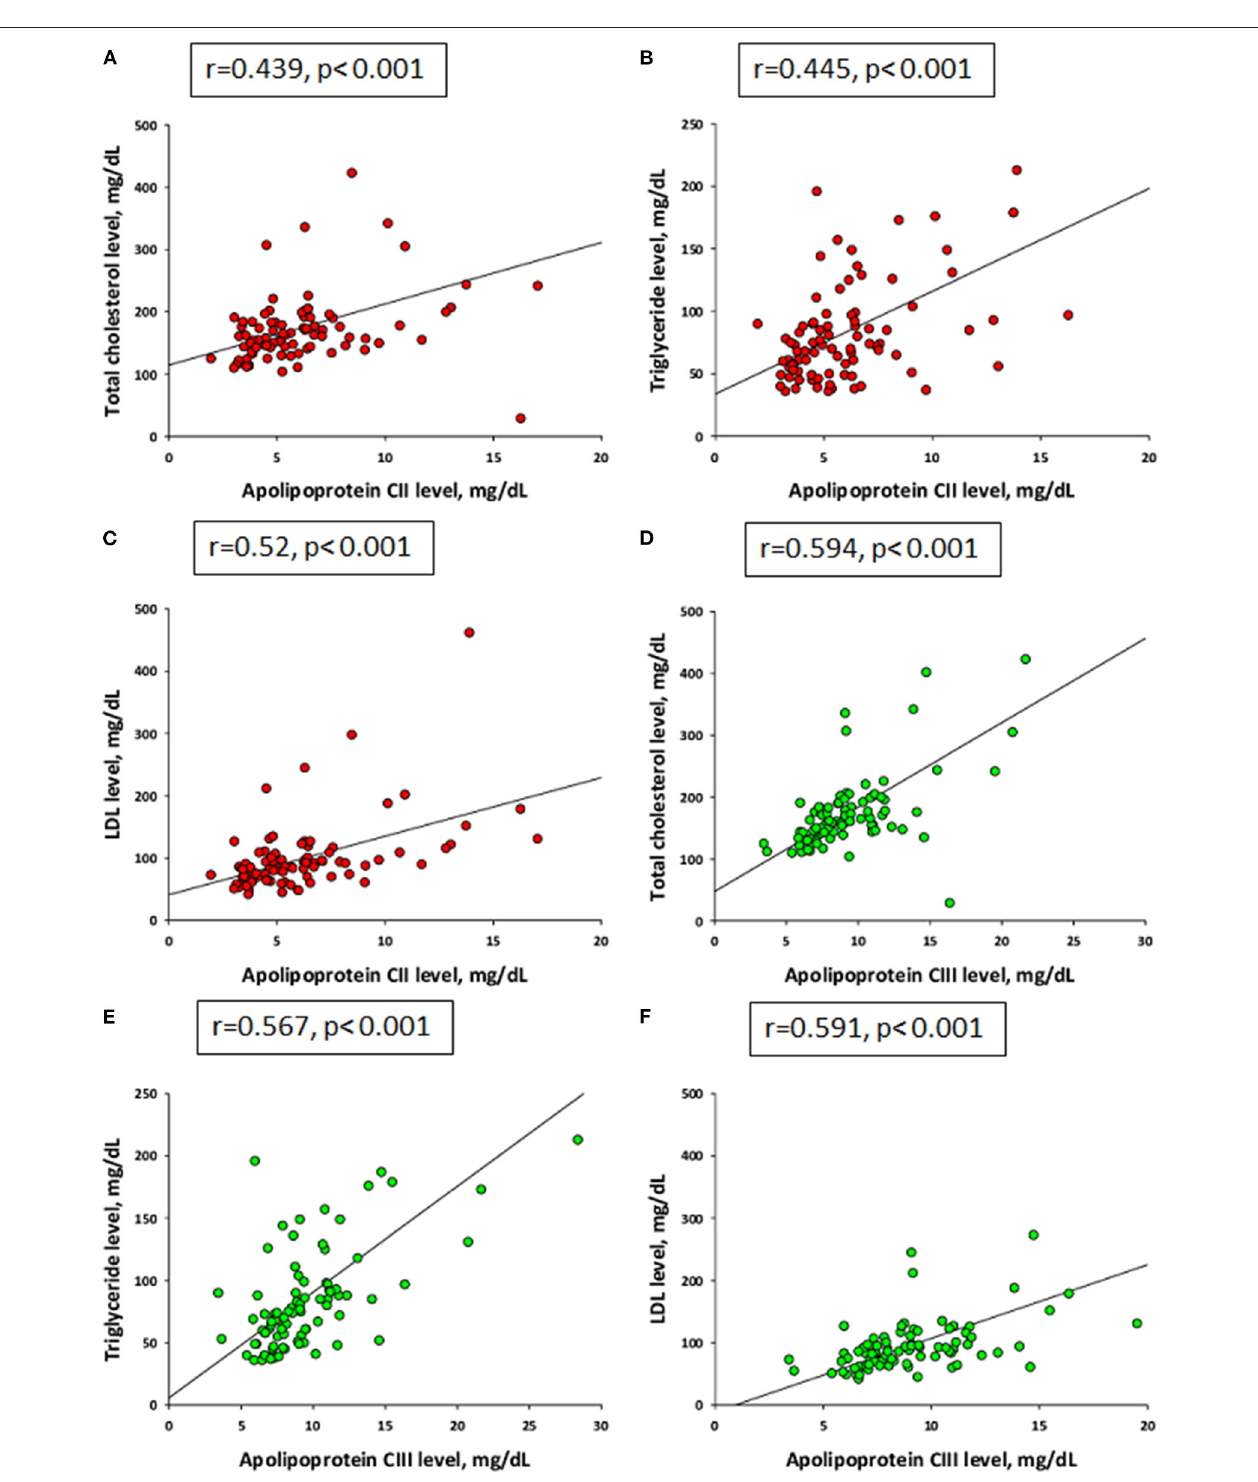
FIGURE 1 | Correlations of plasma levels between apolipoprotein C-II (red) and (A) total cholesterol, (B) triglyceride, and (C) low-density lipoprotein (LDL). Plasma levels between apolipoprotein C-III (green) and (D) total cholesterol, (E) triglyceride, and (F) LDL by Spearman’s correlation coefficient.